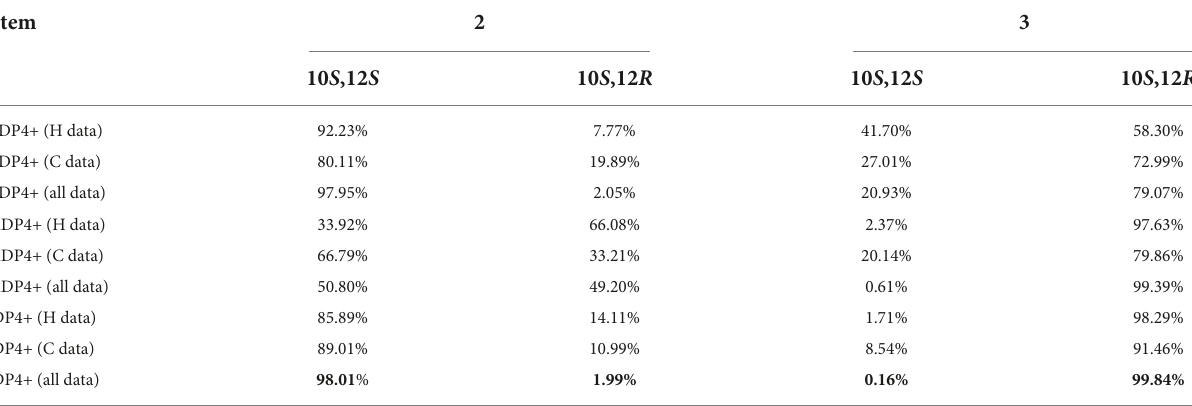
TABLE 2 DP4+ analysis of the (10,12)-stereoisomers with compounds 2 and 3 (sDP4+: scaled chemical shifts; uDP4+: unscaled chemical